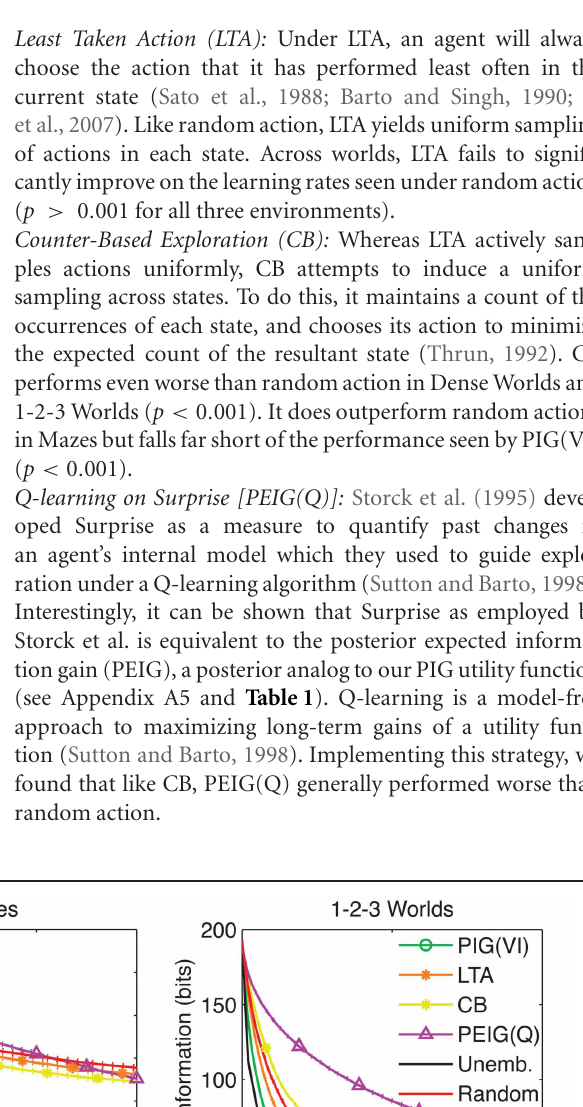
(Thrun, 1992), and Q-Learning on posterior expected information gain [PEIG(Q)] (Storck et al., 1995). The standard control strategies are also shown. Standard errors are plotted as dotted lines above and below learning curves ( n =